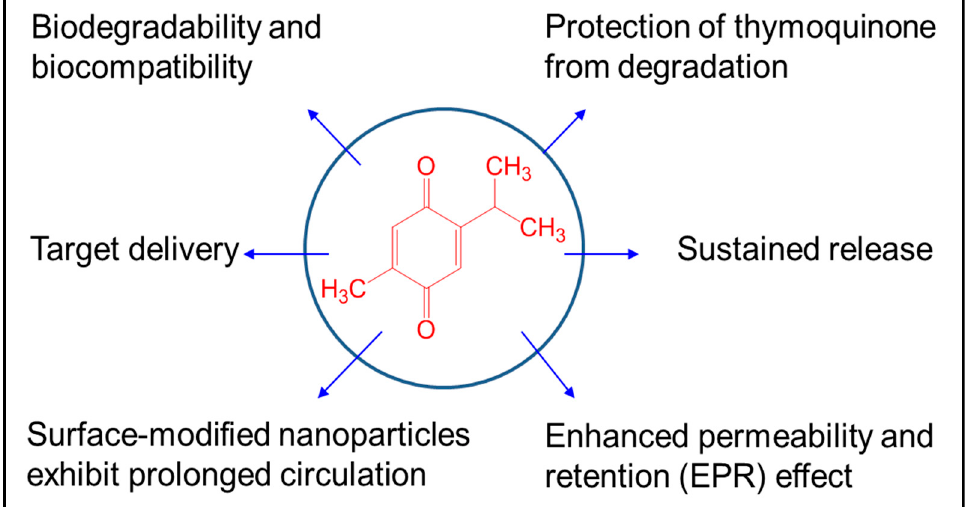
Figure 2. Advantages of thymoquinone nanoformulations.